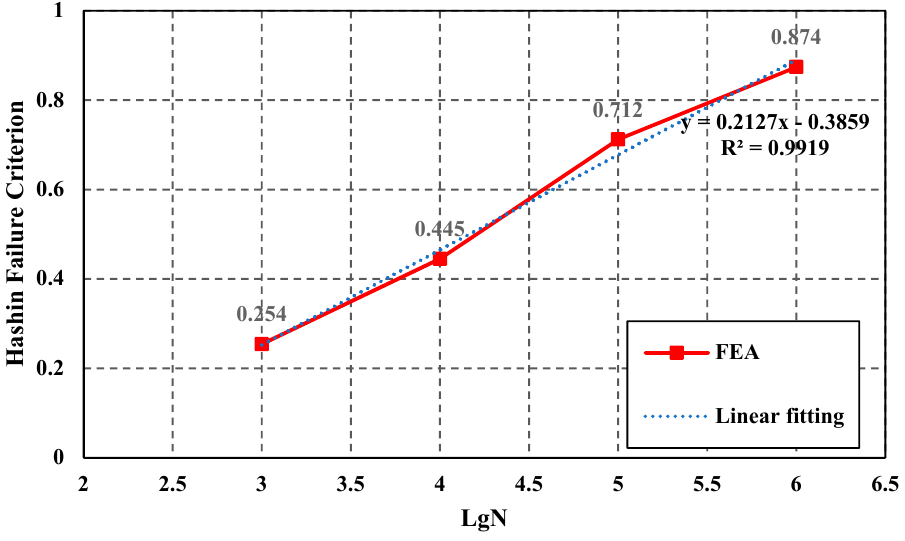
Figure 9. lgN-HFC correlation relationship.